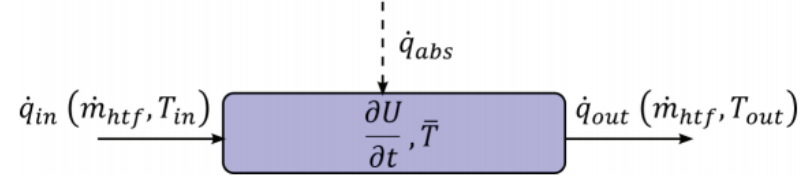
Figure 5. Heat balance over a node. Taken from Wagner et al. [26].